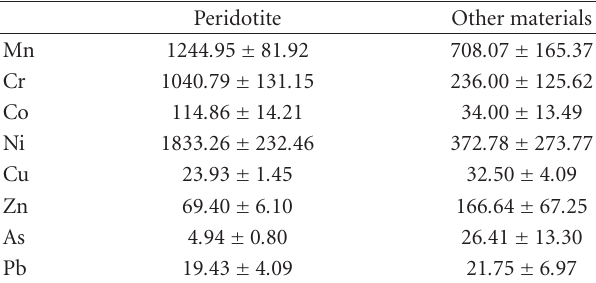
Table 1: Total heavy-metal concentrations (mgkg − 1 ) in sediments from peridotite materials and from other materials in the Verde River basin.